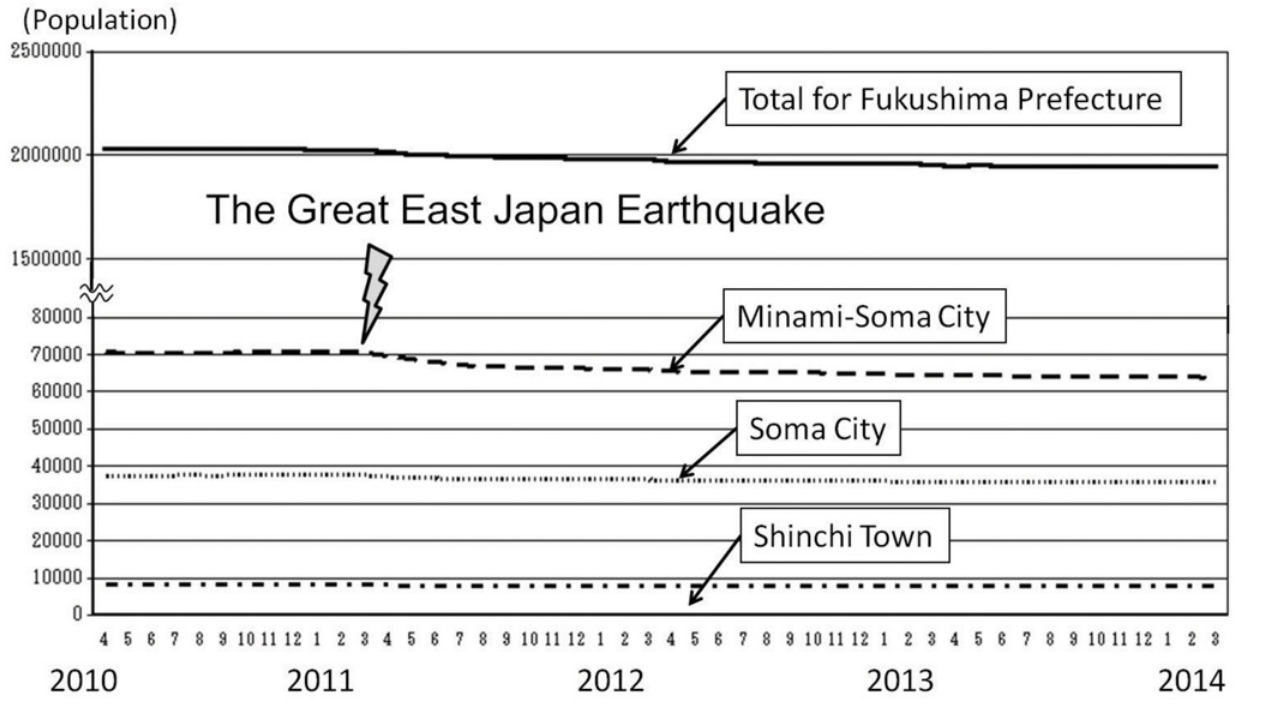
Fig 2. Demographic transition in Soma City, Minami-Soma City, and Shinchi Town (excerpt from Fukushima Prefectural Home Page: http://www. pref.fukushima.lg.jp/). After the disaster, many people voluntarily evacuated to other places without changing their residence registry. The exact number of those refugees has not been counted by the local governments as yet, but the population decreased by 4.4% in Fukushima Prefecture, 5% in Soma City, 9.6% in Minami-Soma City, and 6.9% in Shinchi Town.